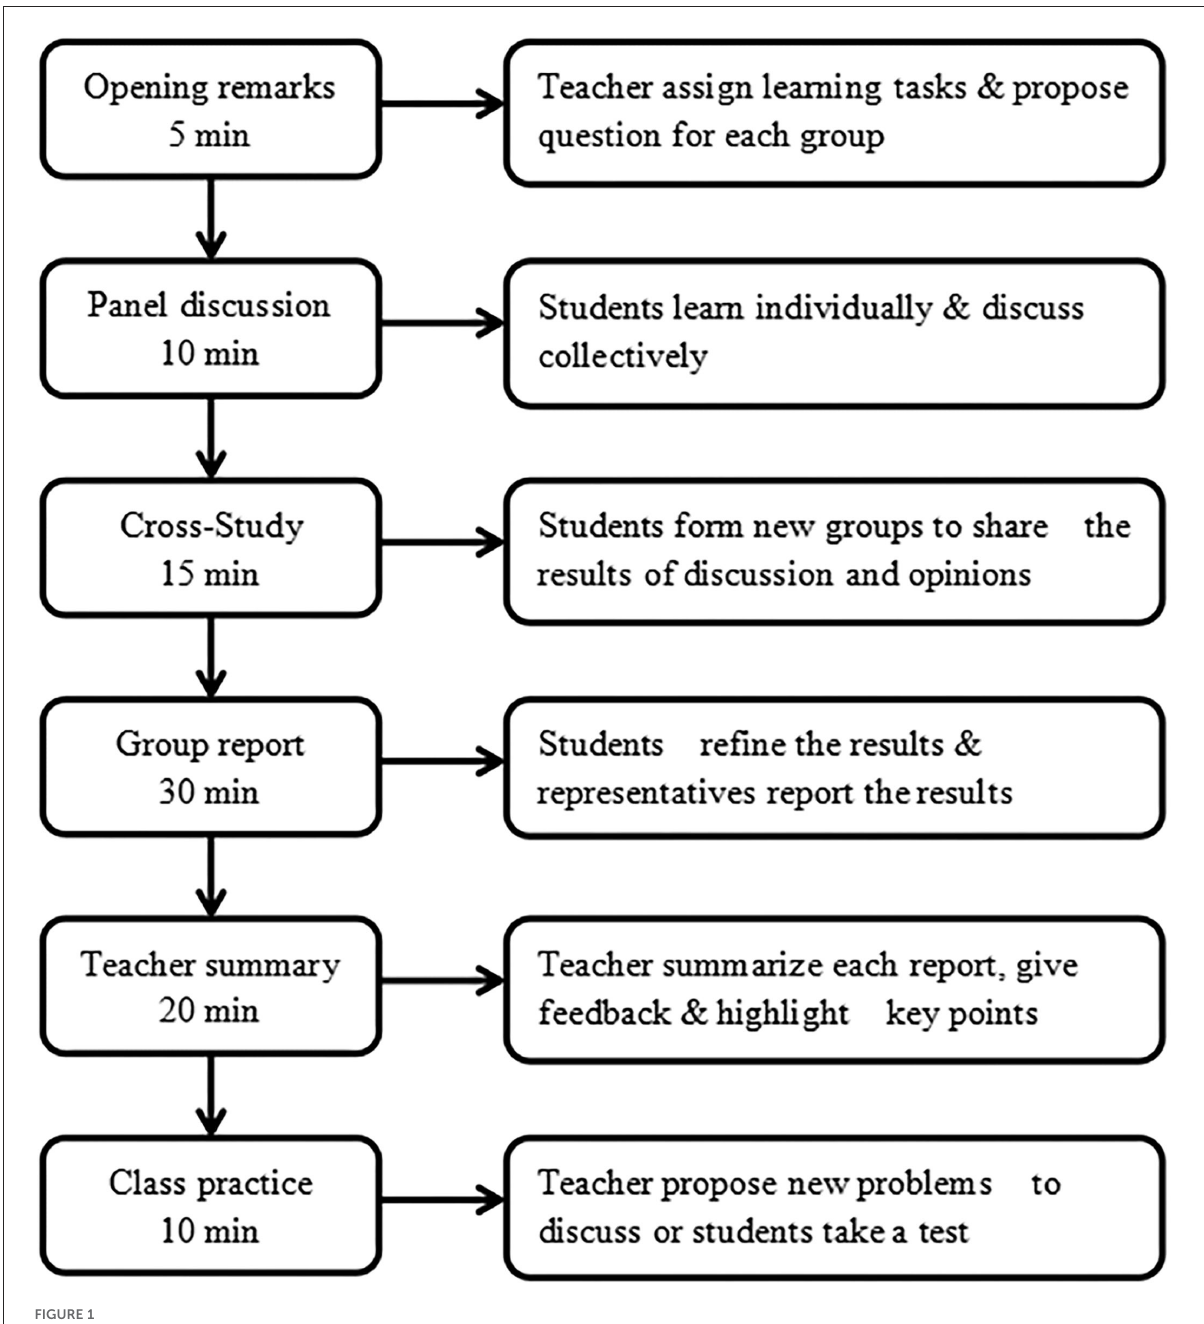
FIGURE1 The teaching frame of Sandwich